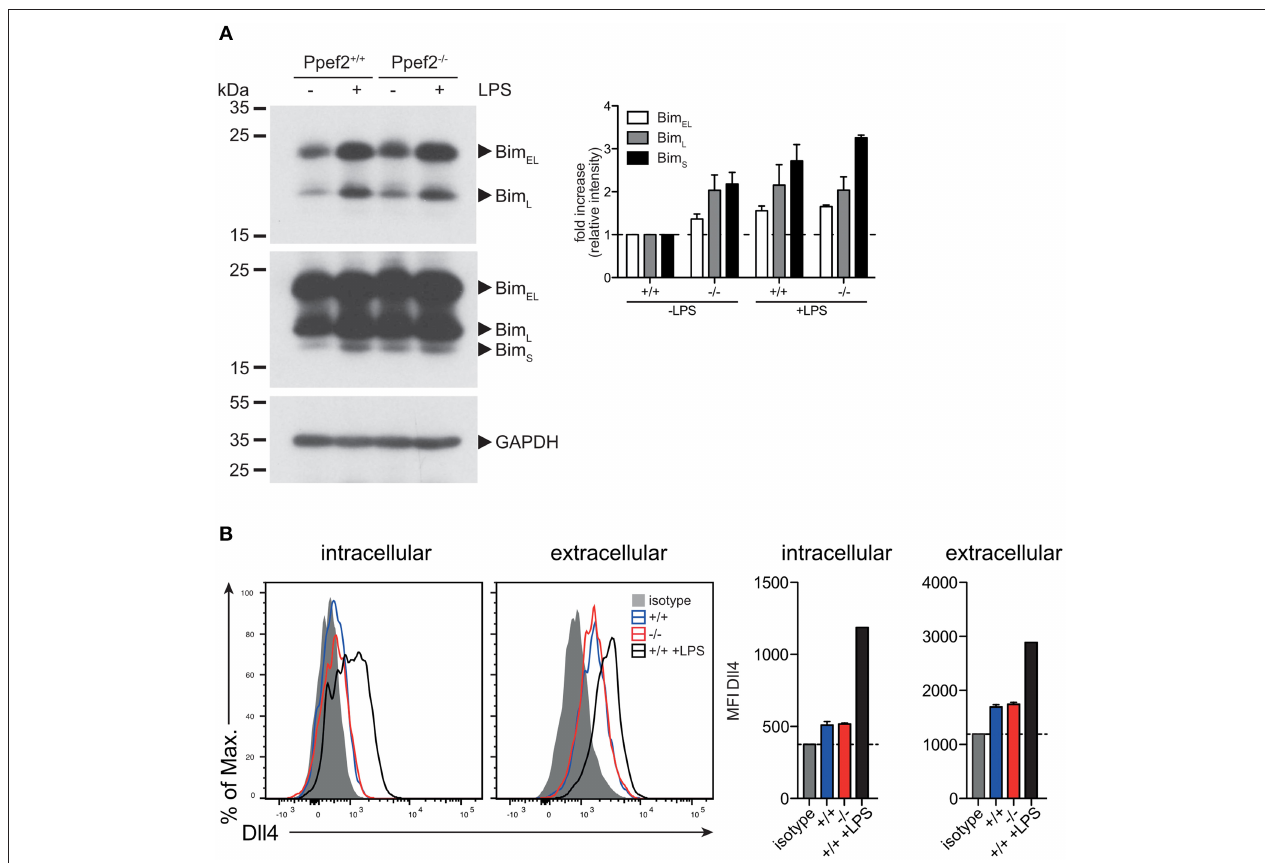
FIGURE 6 | Ppef2 − / − DCs have elevated levels of pro-apoptotic BIM. (A) Western blot for Bim was performed with 30 µ g cell lysates of GM-CSF BMDCs either unstimulated or LPS matured. Exposure for 30s allowed detection of BimEL and BimL isoforms ( A left, top panel); 5min exposure revealed the BimS isoform in addition ( A left, middle panel). Intensities of the bands for all three Bim isoforms were quantified relative to the GAPDH loading control ( A left, lower panel) by using ImageJ and fold increase was calculated relative to the untreated Ppef2 + / + control ( A , right hand panel). Two western blots were performed and shown are pooled normalized intensities. (B) Surface staining of Dll4 was performed with fluorescently labeled antibody and protein abundance was measured by flow cytometry. Shown are representative FACS plots (left) and mean ± SEM of the mean fluorescence intensity of n = 3 mice.